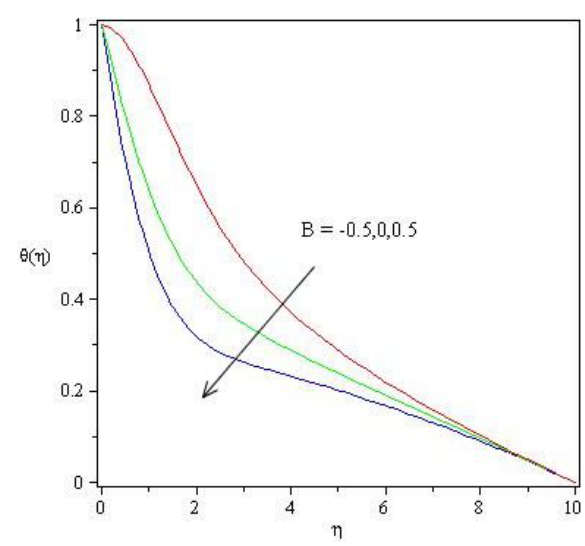
Fig. 19: Temperature profile for different values of B = −0.5, 0, 0.5, 1 and p = 1, pr = 1, M = 0.5, B = 0.5, n =